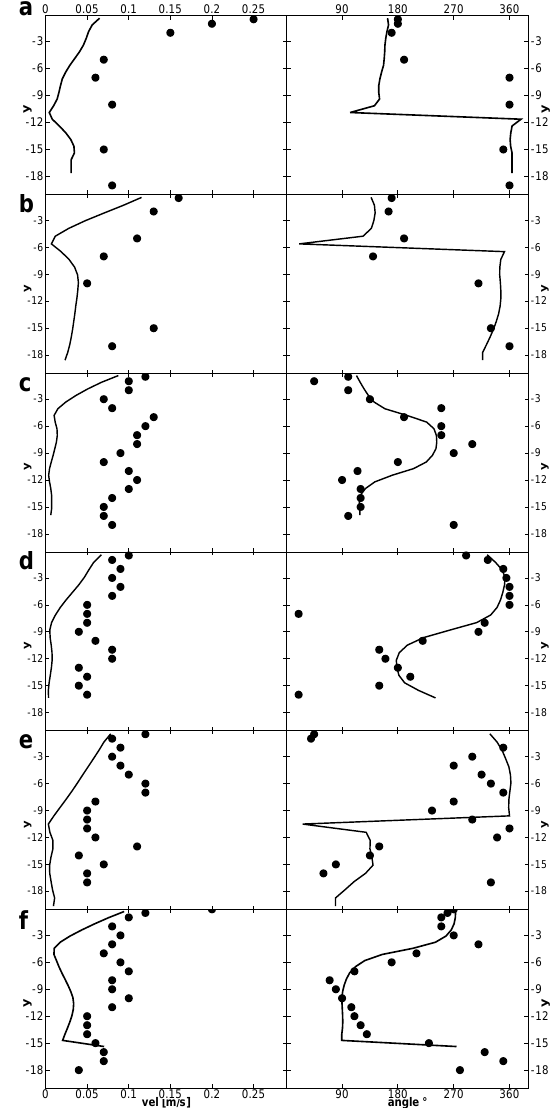
Fig. 11. Left panel: velocity module; right panel: velocity direction, 90,180,270,360 refer to east, south, west, north respectively. Solid line: numerical profile; circle: measurements. a) station s1; b) sta- tion s3; c) station s44; d) station s47; e) station s48; f) station s49.